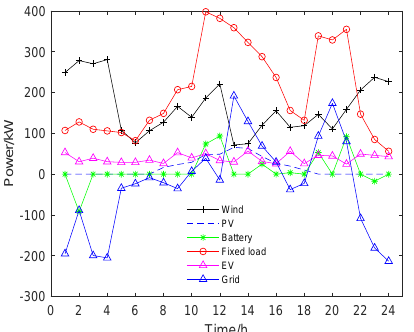
Figure 12. The output of each unit under the objective function solving by QMA.